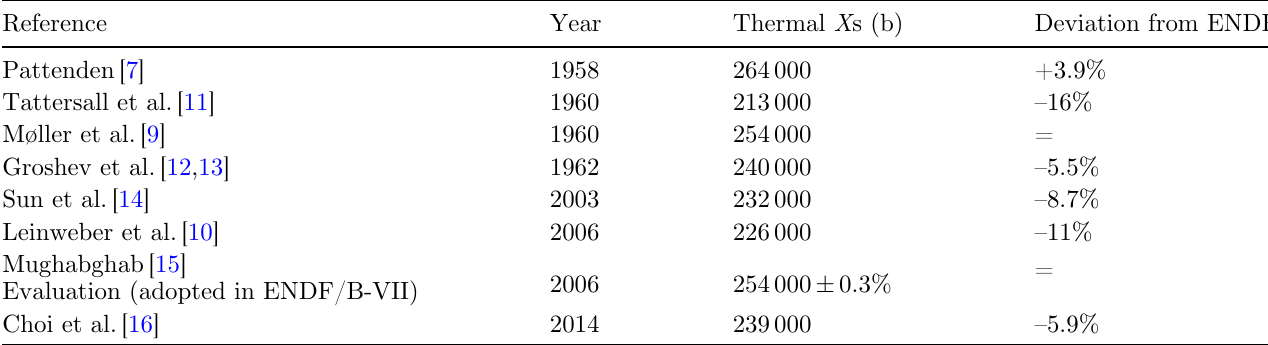
Table 1. List of evaluations of 157 Gd thermal capture cross sections as reported in scienti fi c